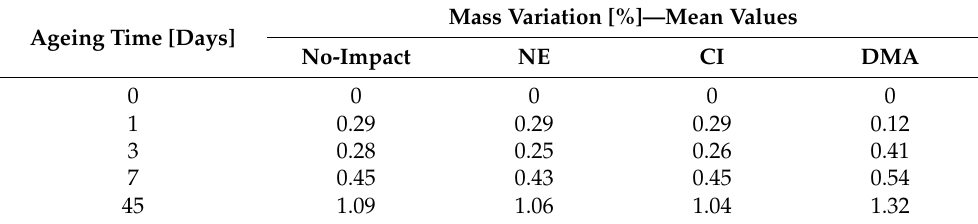
Table 2. Mass variation mean values comparison.